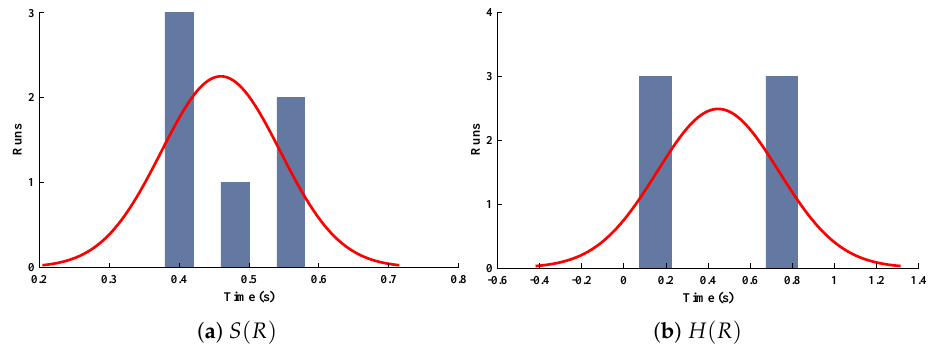
Figure 17. Normal probability curves for the computational complexity of different scenarios for ( a ) concentration profiles of substrate and ( b ) hydrogen peroxide of micro-disk